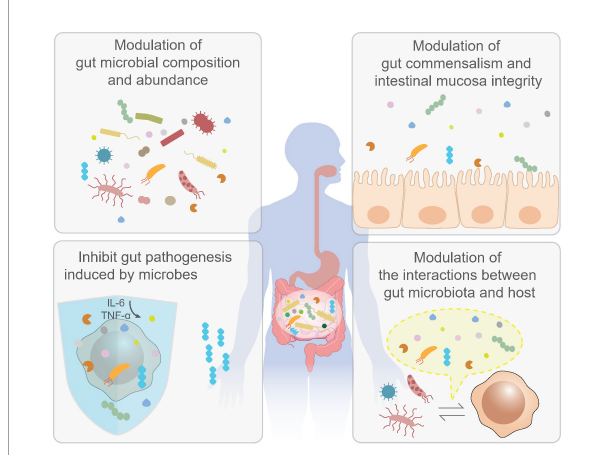
FIGURE3 Biological activities of postbiotics in vivo . The benefits of postbiotics have also been well-documented by enormous in vivo studies. It has been shown that postbiotics are effective in the modulation of gut microbial composition and abundance (upper left); maintaining gut commensalism as well as intestinal mucosa integrity (upper right); inhibit gut pathogenesis induced by gut microbes (lower left) and modulation of interactions between gut microbiota and host and (lower right). These activities may contribute to the prevention and treatment of colorectal cancer